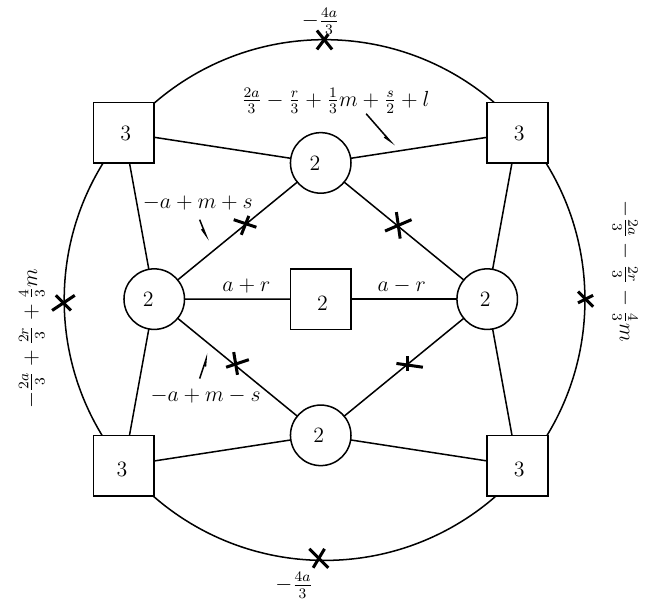
Figure 36 . Leg of torus theory with one unit of (cid:13)ux breaking symmetry to SU(6)U(1) E 6 . Three copies of this model are glued to by gauging the diagonal SU(3) symmetries. The charges under di(cid:11)erent symmetries are deduced from the superpotentials associated to the faces. The (cid:13)ux is for the U(1) a symmetry. The SU(2) (cid:13)avor symmetry with U(1) l symmetry enhances to SU(3) for each leg and the three SU(3)s from the three legs enhance to E 6 .